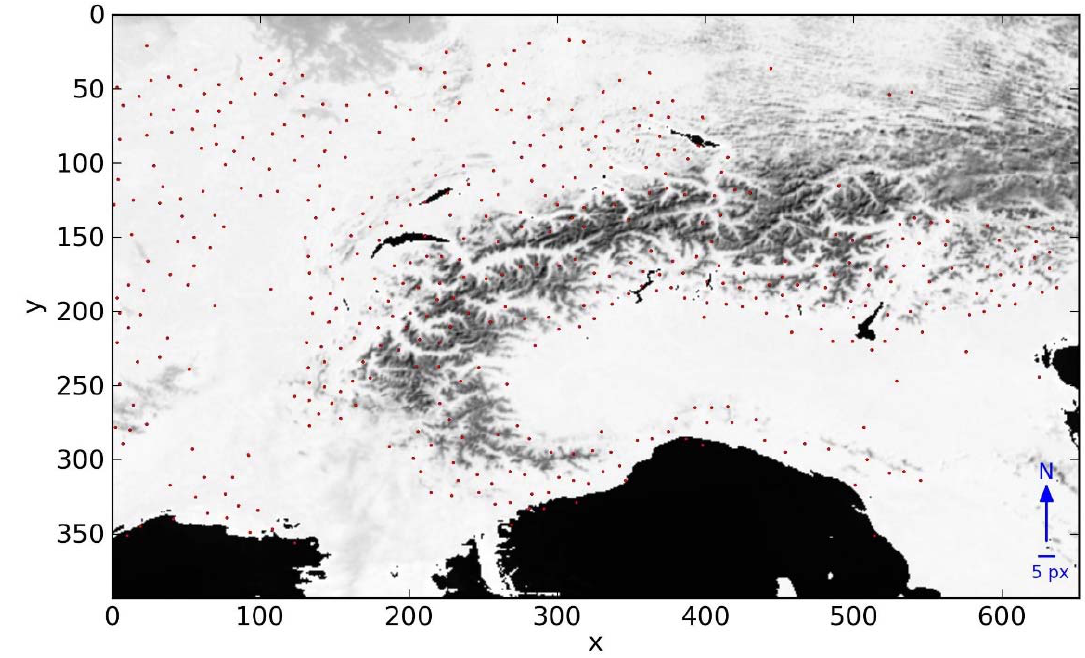
Figure 7. 2D image space residuals between the 10:30 and 10:45 images acquired on 7 February 2008, after removal of the mean 2D shifts. The scale for residual vectors is depicted in the lower